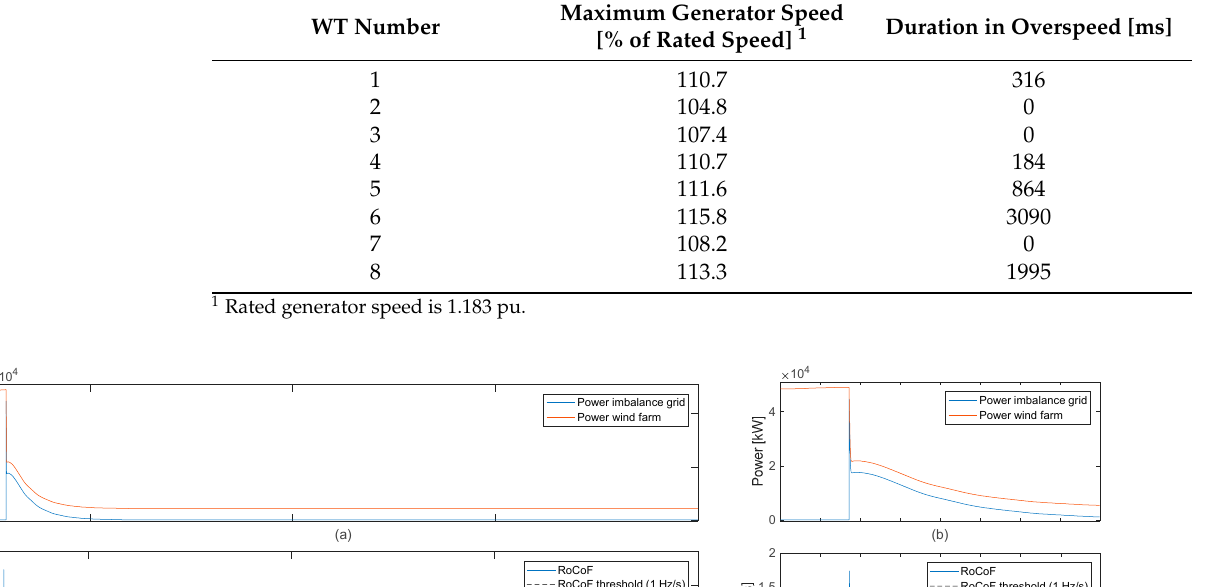
Table 3. Results of scenario I. Maximum speed and duration in overspeed for all simulated WTs.